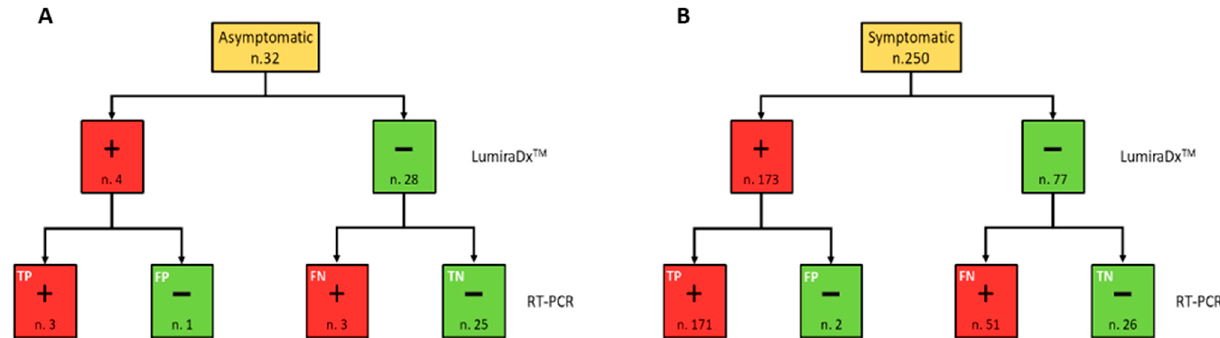
Figure 1. Flow chart summarising the RT-PCR and LumiraDx™ SARS-CoV-2 simultaneously per- formed test results, in accordance with the symptomatic ( A ) and asymptomatic ( B ) clinical status of the study population. Red and green boxes indicate positive (+) and negative ( − ) results for each testing, respectively. While the fraction of false negative results among all of the LumiraDx™ tests compared with real time RT-PCR was not significantly associated with gender ( p = 0.704), a moderately significant difference among the various age groups (0–39 vs. 60–79; p = 0.048) was regis- tered. Finally, false negative rates were significantly less common among asymptomatic subjects than both among pauci-symptomatic subjects ( p = 0.002) and those diagnosed with pneumonia ( p = 0.009). The false positive fraction did not significatively differ among the various subgroups (Table 1). Table 1. Relationship between the test analysis results and clinical variables .